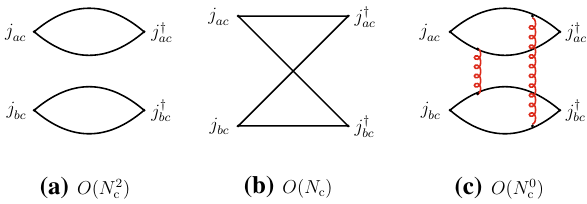
Fig. 16 Leading and subleading diagrams of the correlation function (3.12)